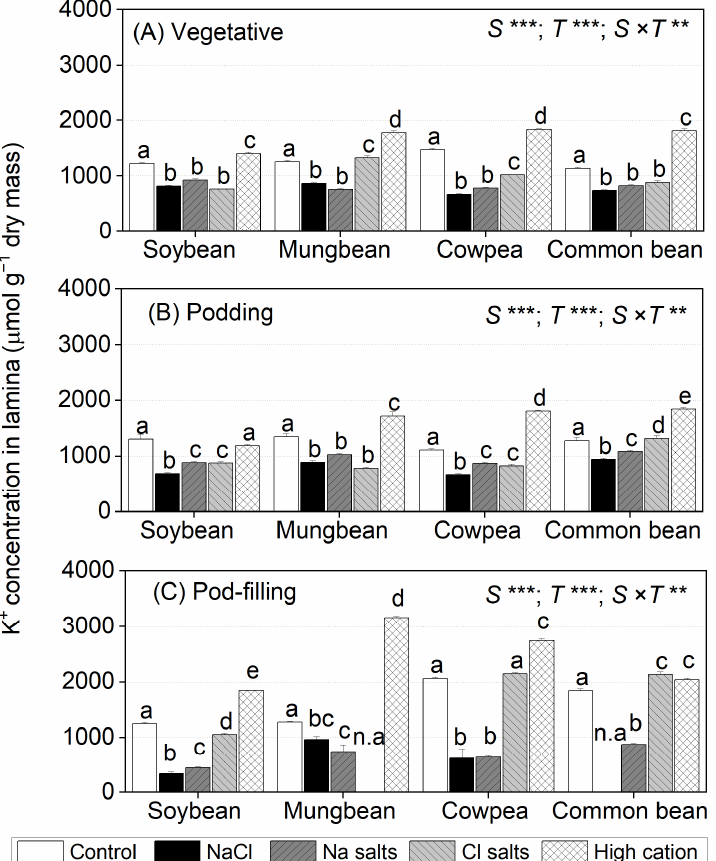
Figure 4. K + concentrations in lamina of soybean, mungbean, cowpea, and common bean grown in control (non-saline), 100 mM NaCl, 100 mM Na + (without Cl − ), 100 mM Cl − (without Na + ), and high-cation negative control (K + , Mg 2+ , and Ca 2+ equivalent to those in the 100 mM Cl − treatment) treatments. The salts used in the various treatments are given in Table 1. The treatments were imposed on 13-day-old plants and sampled after ( A ) 15 (vegetative stage), ( B ) 36 (podding stage), and ( C ) 57 (pod-filling stage) days of treatment. The values are means ± SE ( n = 4). Significant differences for treatment means within each species are indicated by different letters (a–d) ( p = 0.05). The probability levels for two-way ANOVA were used to compare species (S), treatment (T), and species × treatment interaction (S × T) effects (** p < 0.01 and *** p < 0.001). Note: Mungbean subjected to Cl − (without Na + ) and common bean subjected to the NaCl treatment did not have enough green leaf lamina at the pod-filling stage for ion analysis, as indicated by n.a. K + concentrations in shoots, roots, petioles, and stems are presented in Table S2, Figure S6–S7; K + concentrations in flowers, pod walls, and seeds are presented in Table S4, Figure S10.